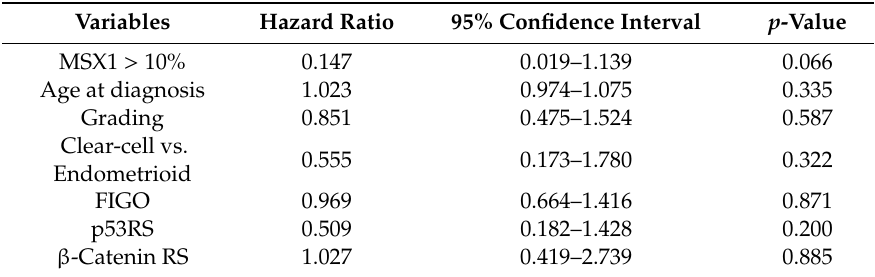
Table 1. Multivariate Cox regression analysis for MSX1.